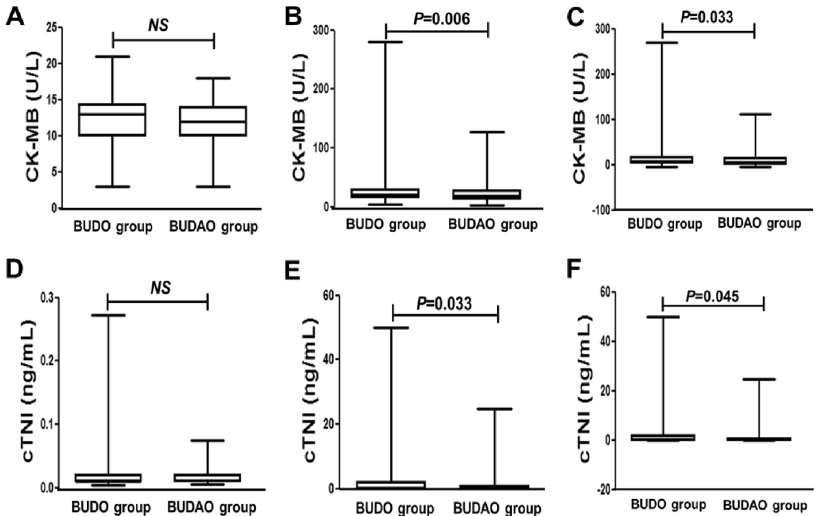
Figure 2. Levels of myocardial biomarkers before and after ePCI in the BUDO and BUDAO groups. ( A , B ) CK-MB levels between two groups before and after PCI; ( C ). CK-MB changes between two groups before and after PCI; ( D , E ). cTNI levels between two groups before and after PCI; ( F ) cTNI changes between two groups before and after PCI. NS, Not significance. Data were expressed as median (Q1, Q3).